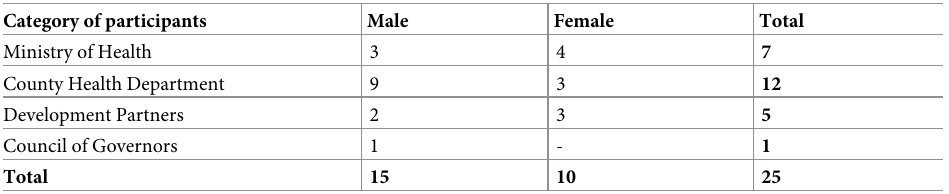
Table 1. Number of study